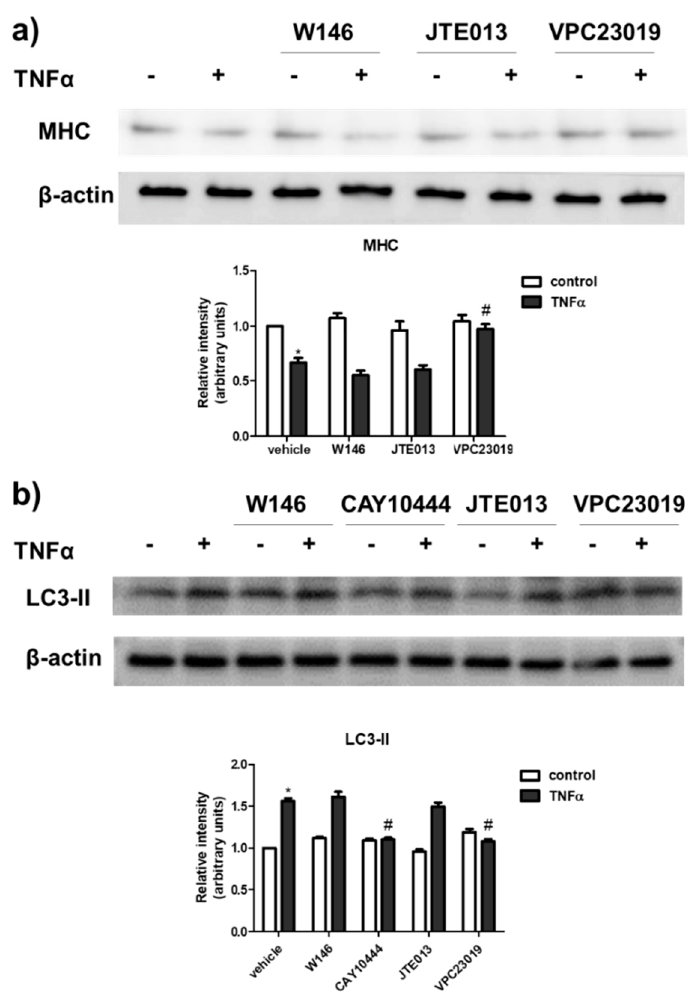
Figure 5. S1P 3 is involved in TNF α -induced effect in C2C12 myotubes. C2C12 myotubes were pre-treated with S1PR specific antagonists (10 µ M W146, selective antagonist of S1P 1 , or 1 µ M JTE013, selective S1P 2 antagonist, or 5 µ M CAY10444, selective S1P 3 antagonist or 1 µ M VPC23019, selective S1P 1 /S1P 3 antagonist) for 1 h before being challenged with 100 ng/mL TNF α for 24 h. The content of MHC ( a ) and LC3-II ( b ) was analysed by Western blotting of whole cell lysates. A blot representative of three independent experiments with analogous results is shown. The histograms represent the densitometric analysis of at least three independent experiments; data are the mean ± SEM and are reported as protein expression normalized to β -actin, -fold change over control (set as 1). The effect of S1P 3 inhibition by CAY10444 or VPC23019 on TNF α atrophic effect is statistically significant by two-way ANOVA followed by Bonferroni’s post hoc test (# p >